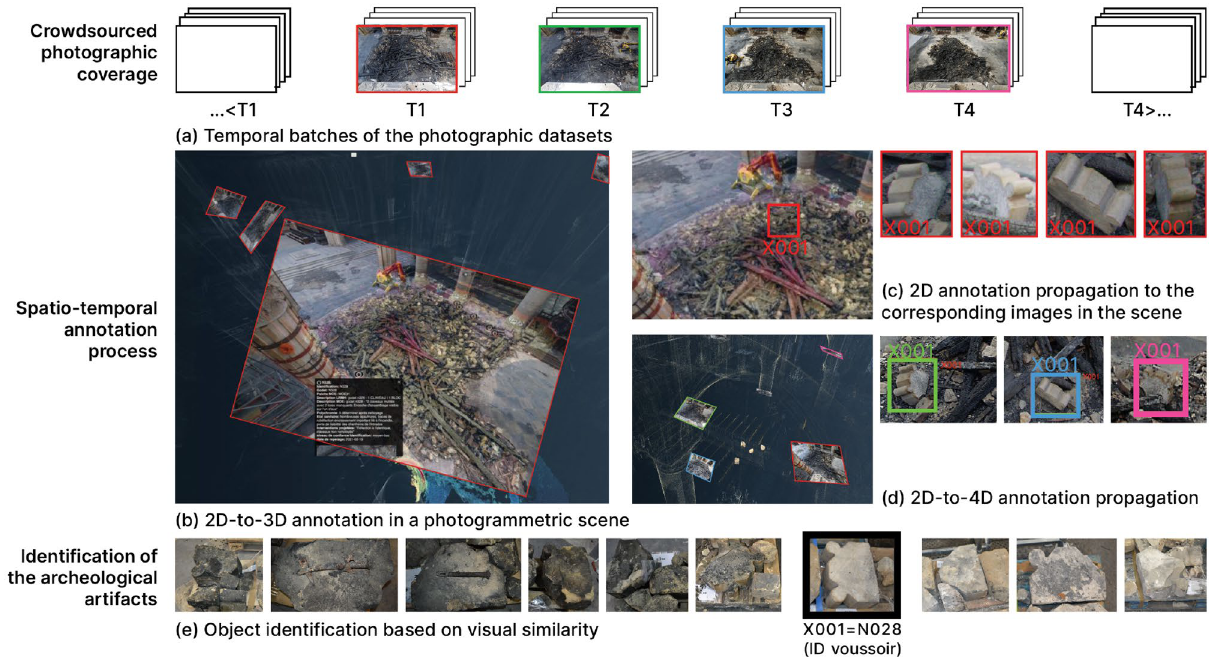
Figure 6. Spatio-temporal tracking in photogrammetric scenes, identification, and annotation of voussoirs in the remains during the recovery operations.